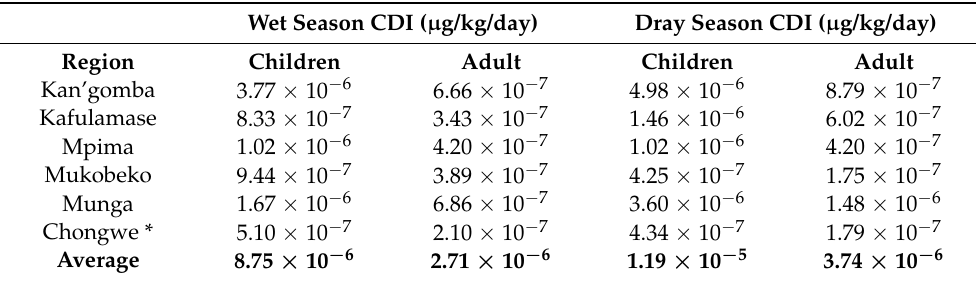
Table 3. Chronic daily intake (CDI) of lead through consumption of milk for the resident children and adults of Kabwe.